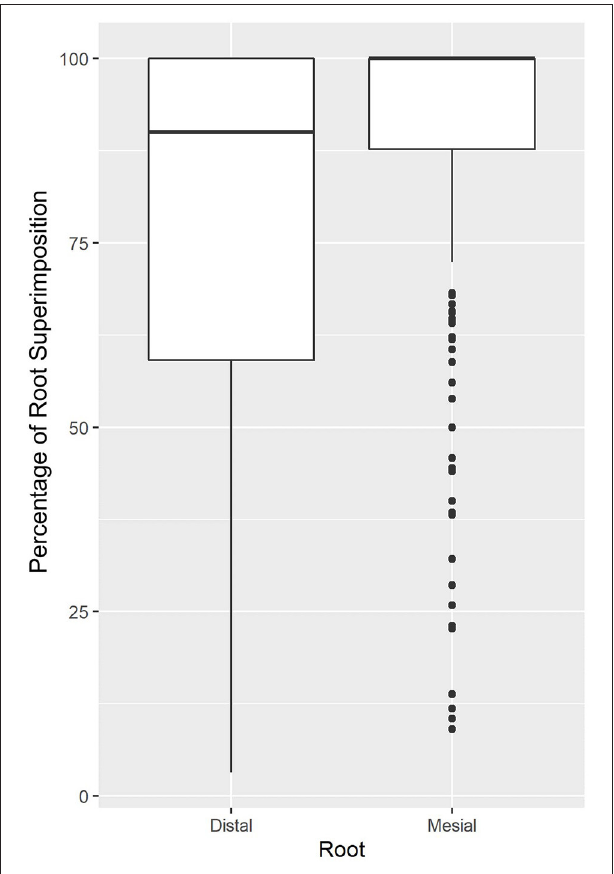
FIGURE 4 | Superimposition percentage for the mesial and distal roots. The graph demonstrates that both distal and mesial roots of M1 showed a significant amount superimposed between the mandibular canal (MC) and M1, with superimposition medians of 90 and 100% for the distal and mesial,